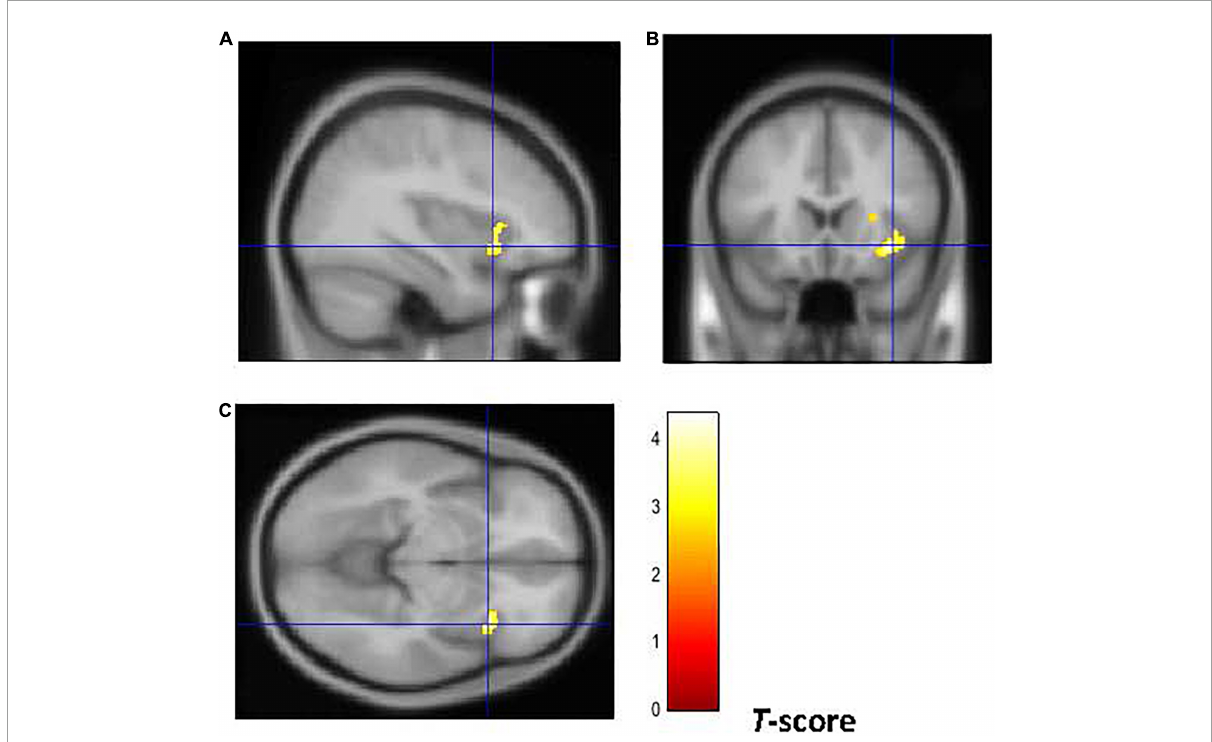
FIGURE5 Brain regions of interest displaying lower WM volume in early onset smokers in comparison to late onset smokers. The figure shows early onset smokers to display lower WM volume in the right AI [region of interest centered at 36, 18, –8 MNI coordinates in sagittal (A) , coronal (B) , and axial (C) planes] in comparison to late onset smokers. The cluster forming threshold consisted in p < 0.01 with a minimum of 100 contiguous voxels per cluster at a whole-brain corrected level. TIV, age, and biological sex were inserted as covariates of no